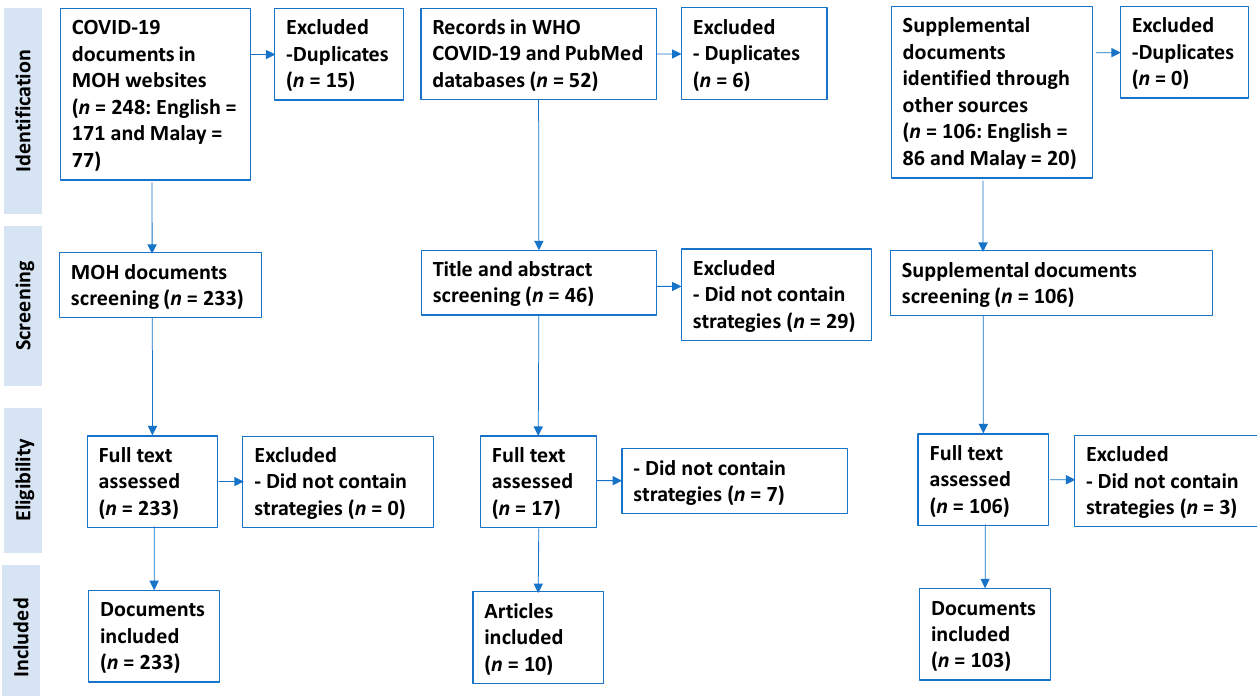
Figure 1. PRISMA flow diagram illustrating document search and selection.